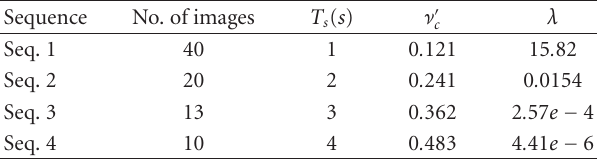
Table 3: Input sequence and filter parameters for every sequence.